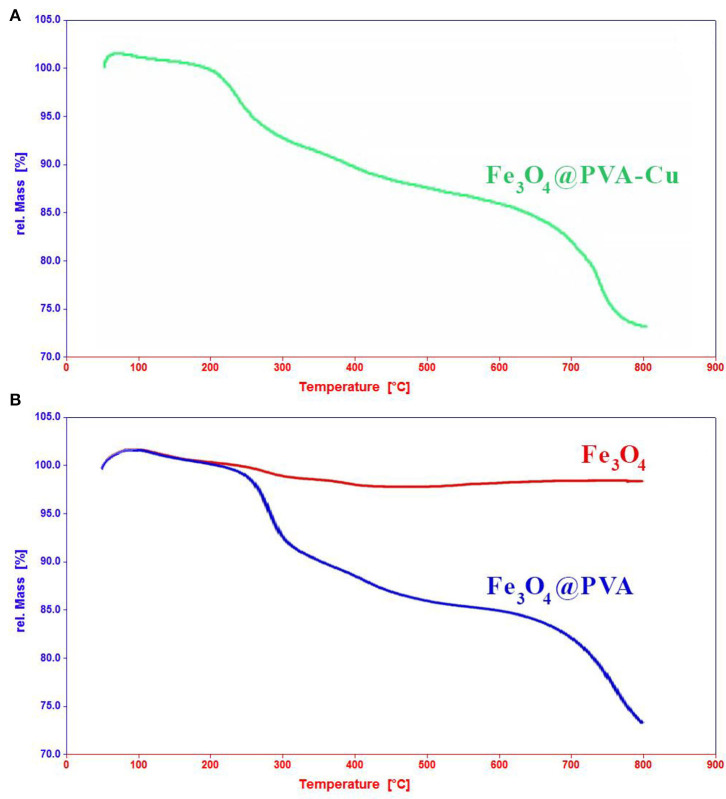
TGA analyses of Fe3O4@PVA-Cu (A), Fe3O4, and Fe3O4@PVA (B) in temperature ranged from 20 to 800°C.